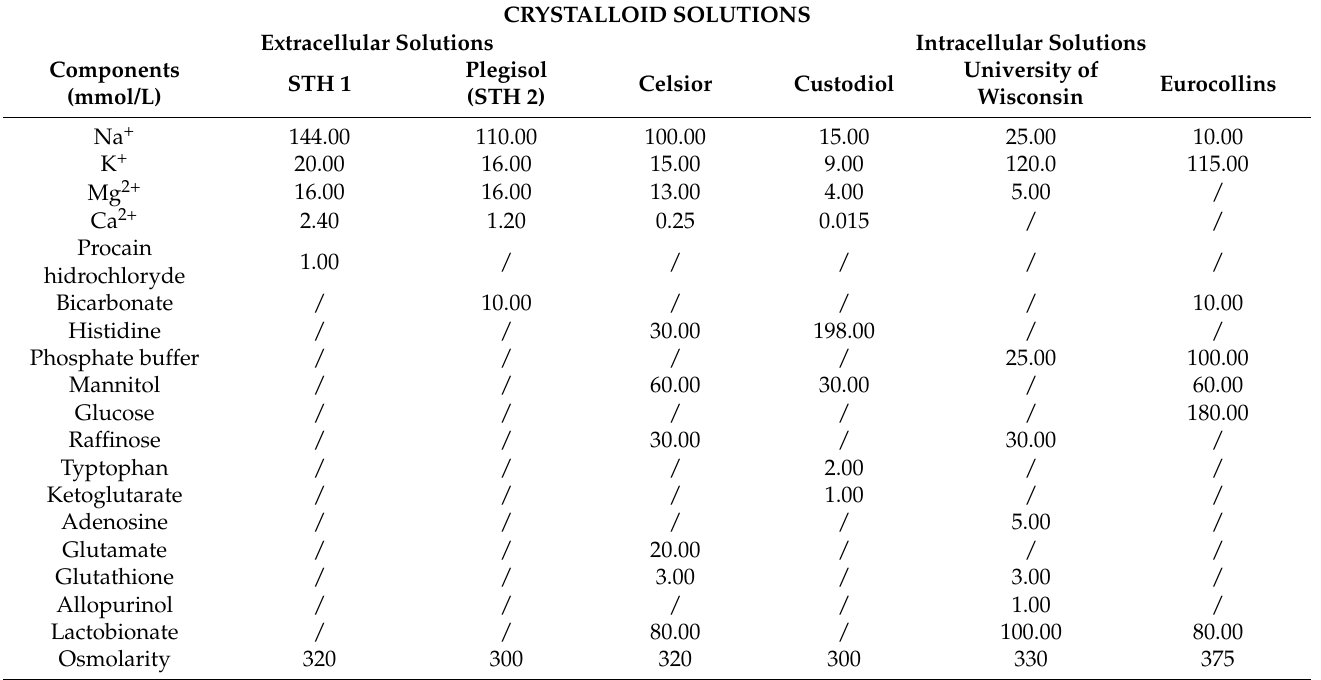
Table 1. Crystalloid cardioplegic solutions. CRYSTALLOID